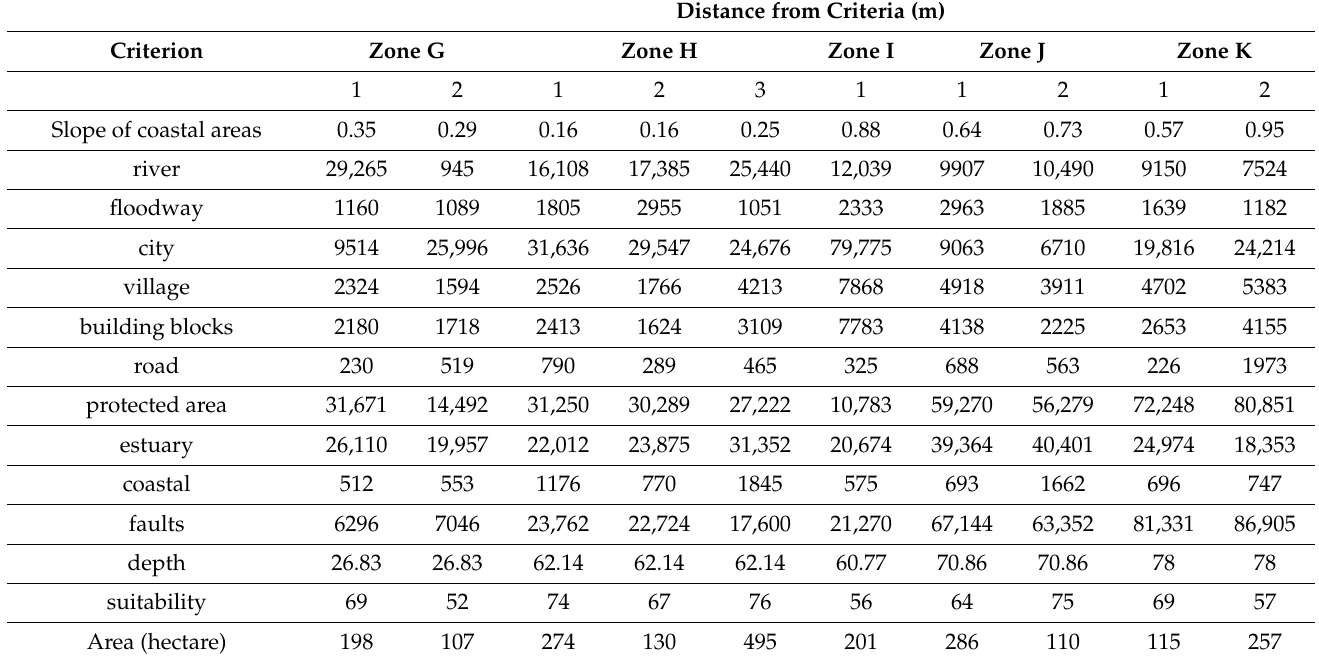
Table 6. The average suitability of the criteria in the western part of region. Distance from Criteria